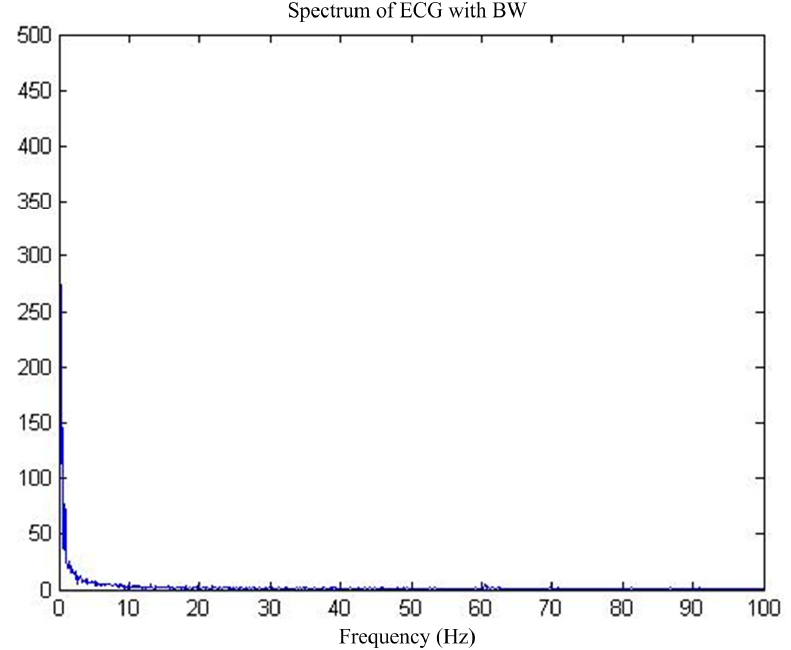
Figure18. ECG spectrum disturbed by BW. Figure 18. ECG spectrum disturbed by